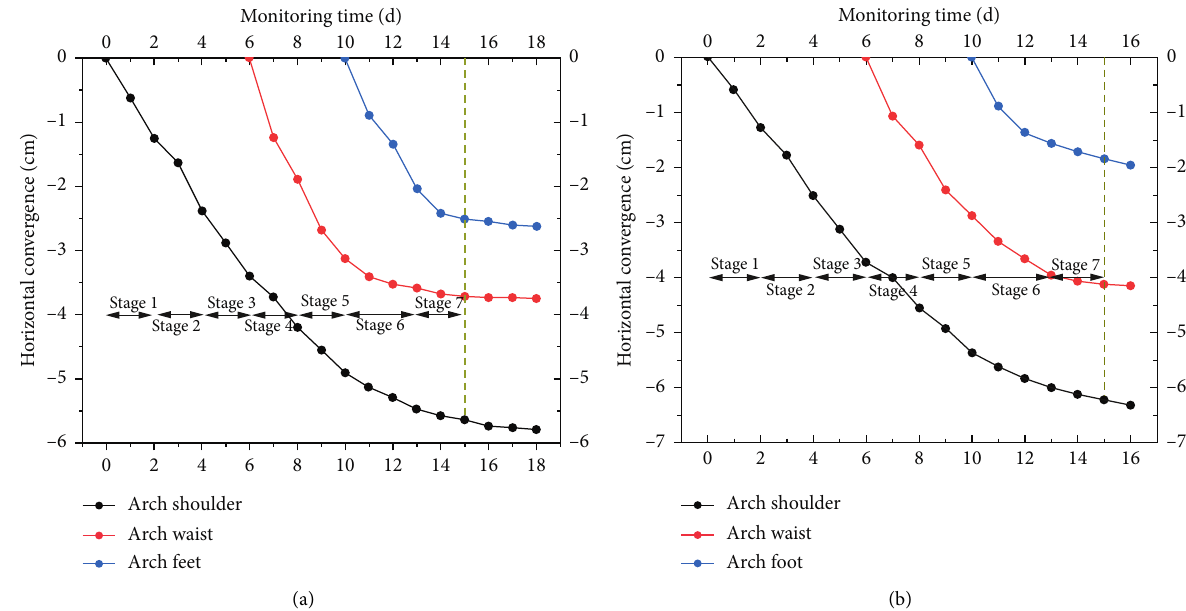
Figure 15: Measured horizontal convergence-time curves of section: (a) ZK1+260; (b)